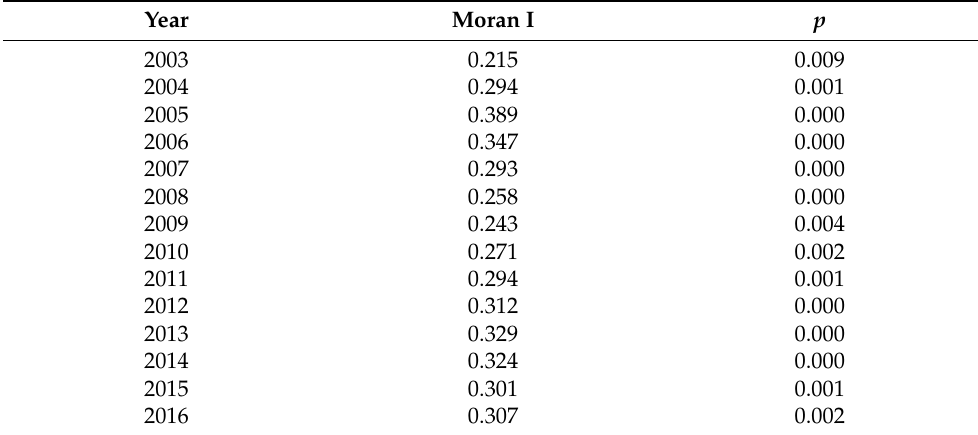
Table 2. Moran’s I of the Belt and Road countries.